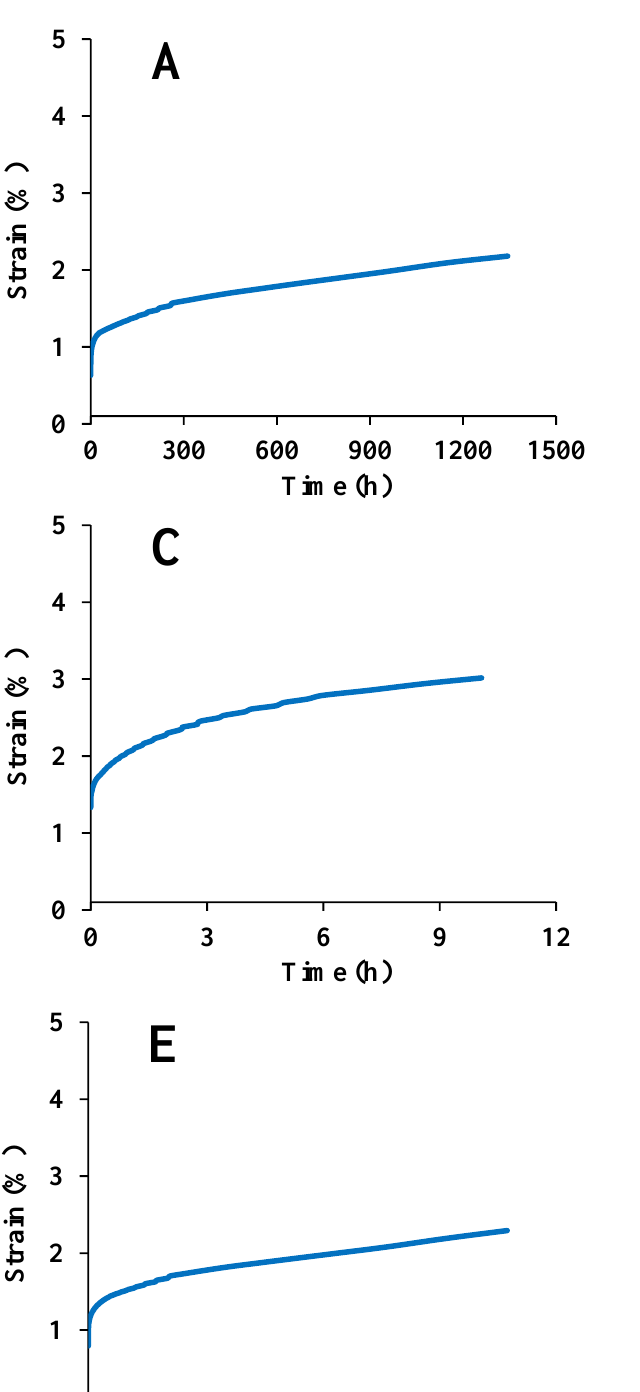
Figure 7. Time-temperature superposition (TTS) predicted stress relaxation for maize kernels dried under different conditions: ( A ) ND; ( B ) HVD 35 °C; ( C ) HVD 45 °C; ( D ) HVD 55 °C; ( E ) HVD 65 °C; ( F ) HVD 75 °C.